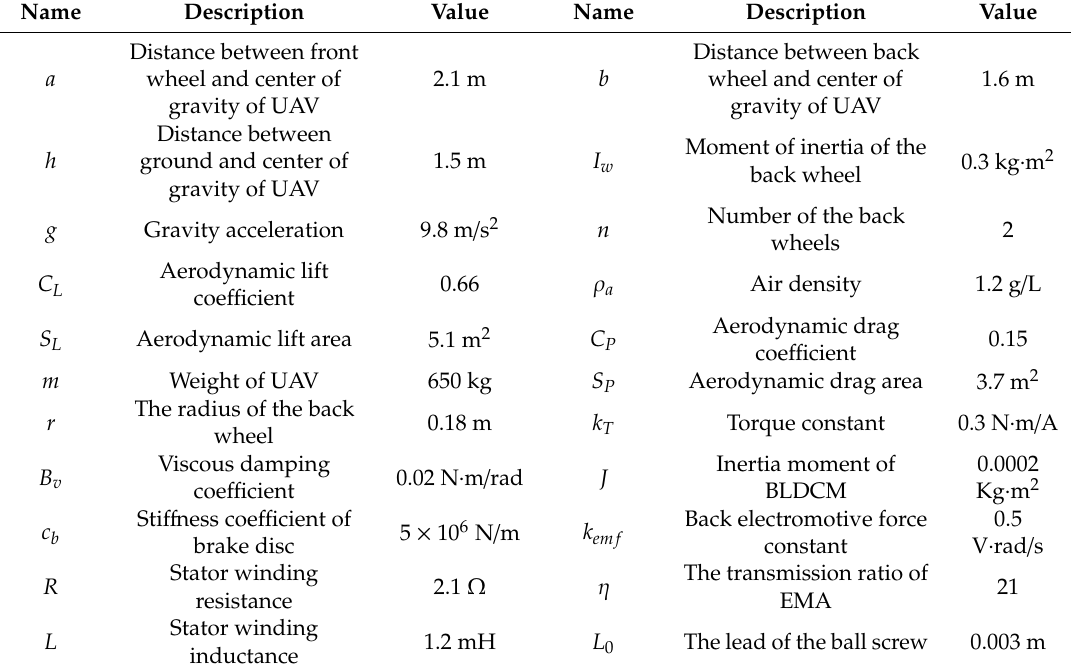
Table 2. Main parameters of the UAV model and EMA model.